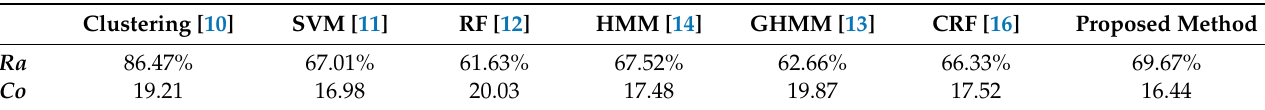
Table 3. Result of scene image gazing with large target